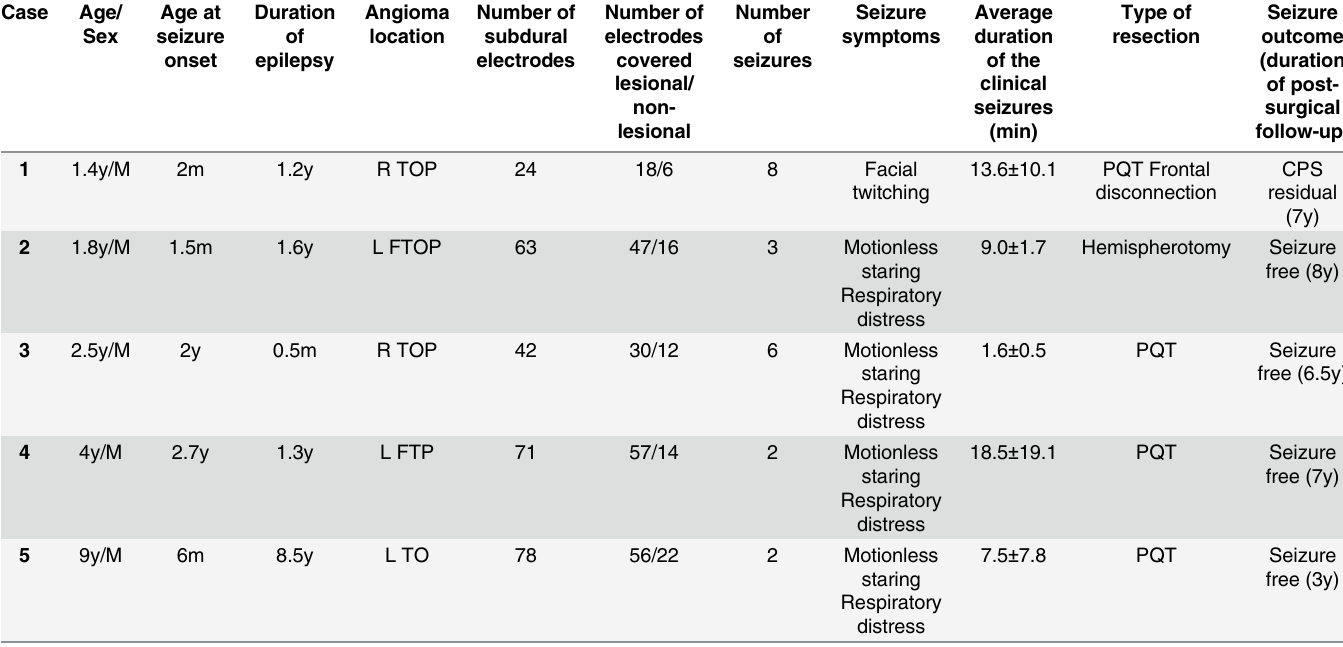
Table 1. Patient demographics and clinical data. F, frontal; P, parietal; T, temporal; O, occipital; L, left; R, right. This study included five SWS patients with progressive mental retardation aged from 1 to 9 years old. Most of the patients presented conspicuous seizure